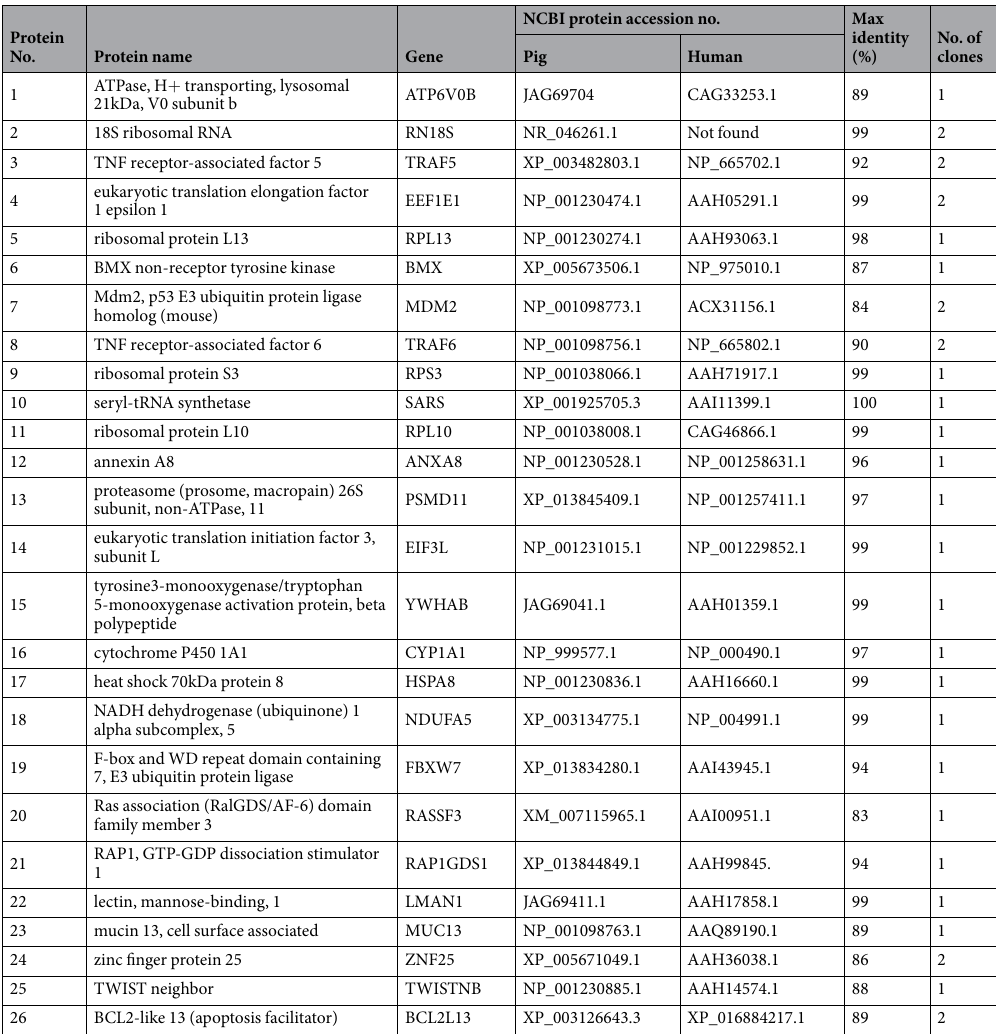
Table 1. The results of the positive clones mating with NS3 BLAST to